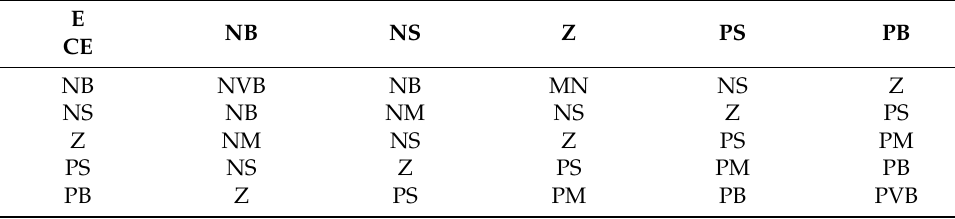
Table 4. FLC rule-based